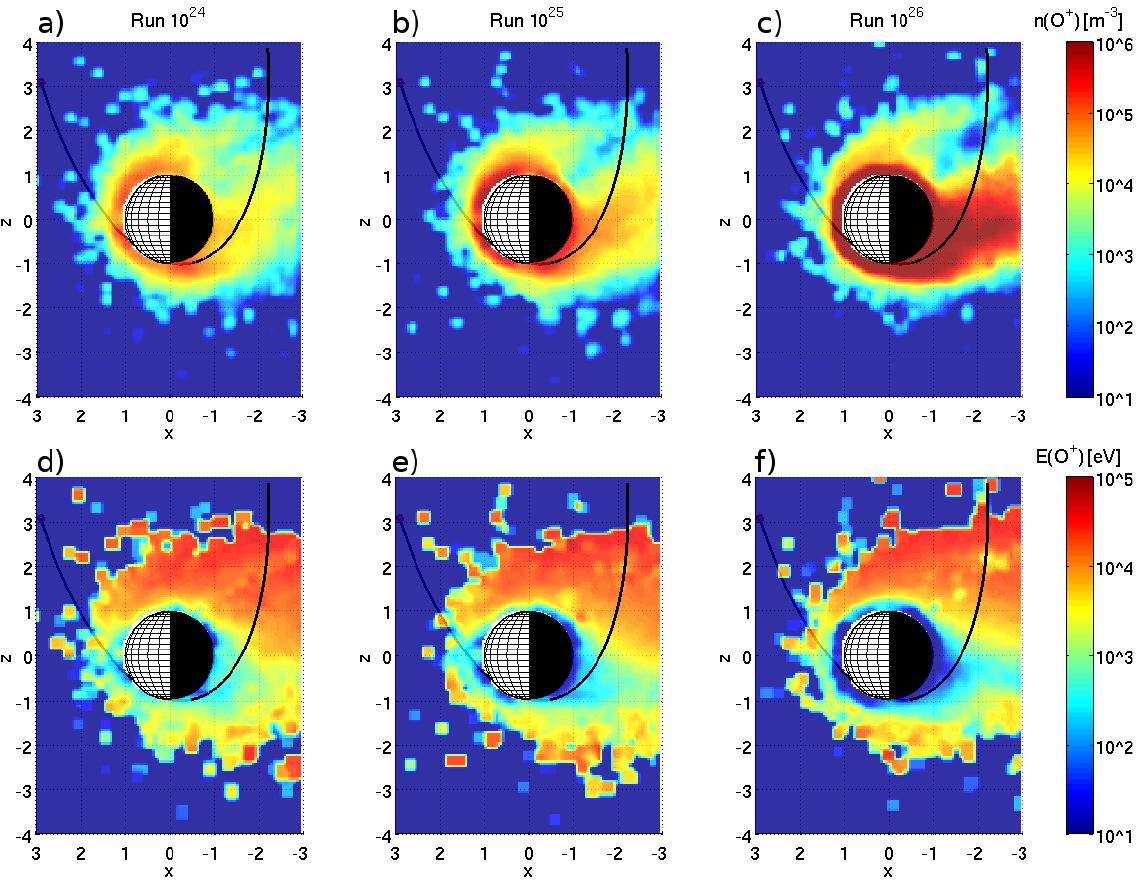
Fig. 8. Density (upper panels) and bulk flow energy (lower panels) of the planetary O + at the y = 0 plane in three HYB-Venus simulation runs with different O + emission rates. The emission rates are (from the left): 10 24 , 10 25 (nominal) and 10 26 s − 1 th